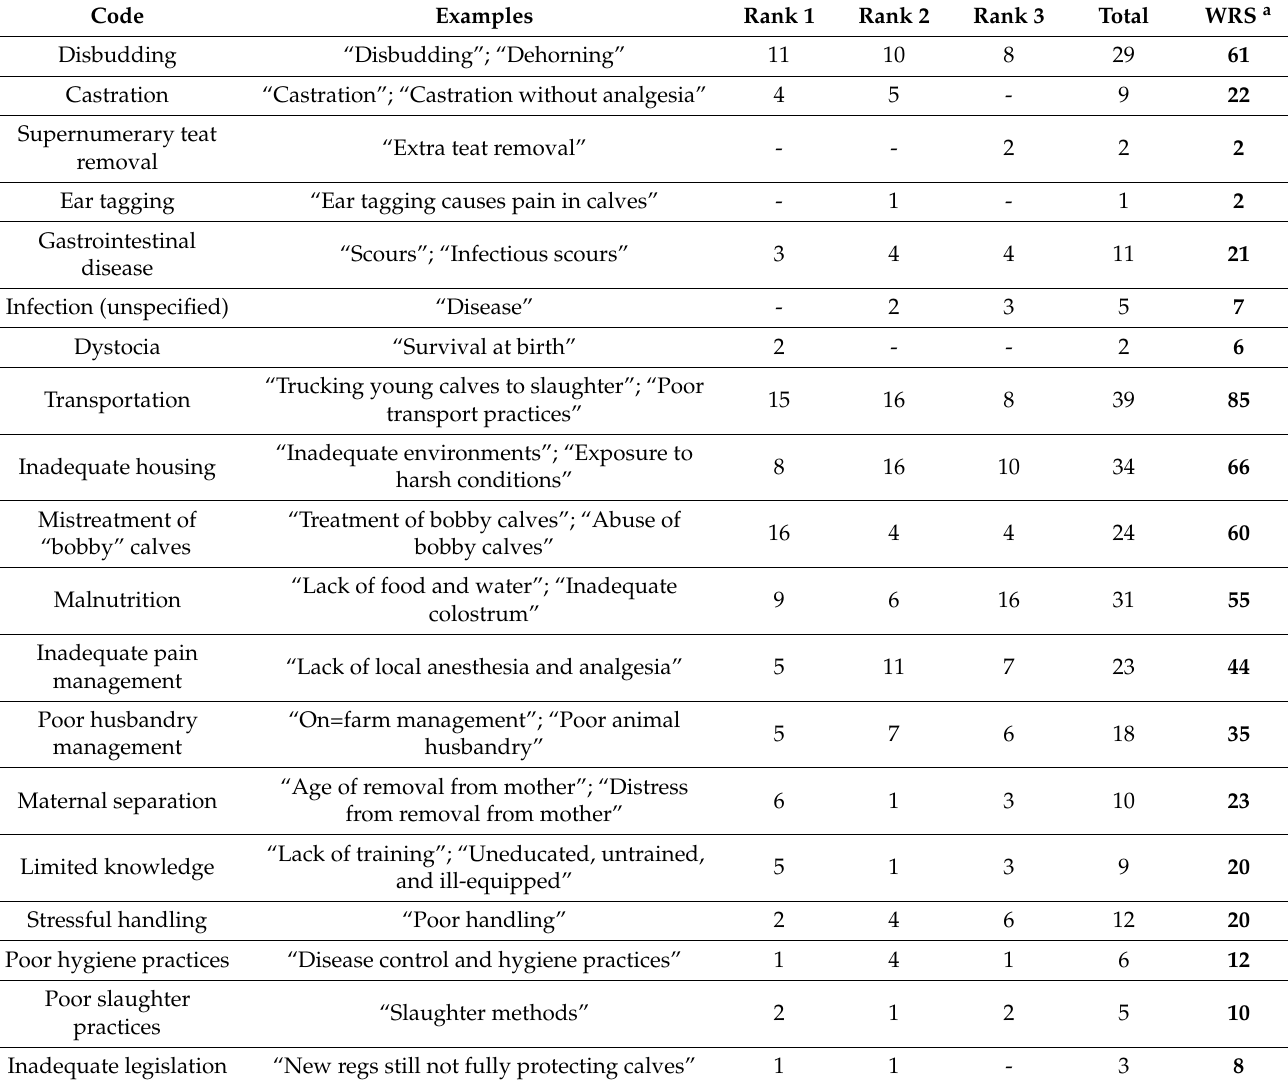
Table A1. Qualitative content analysis of veterinary concerns regarding the areas at highest risk of welfare compromise in calves using a weighted rank score (WRS).